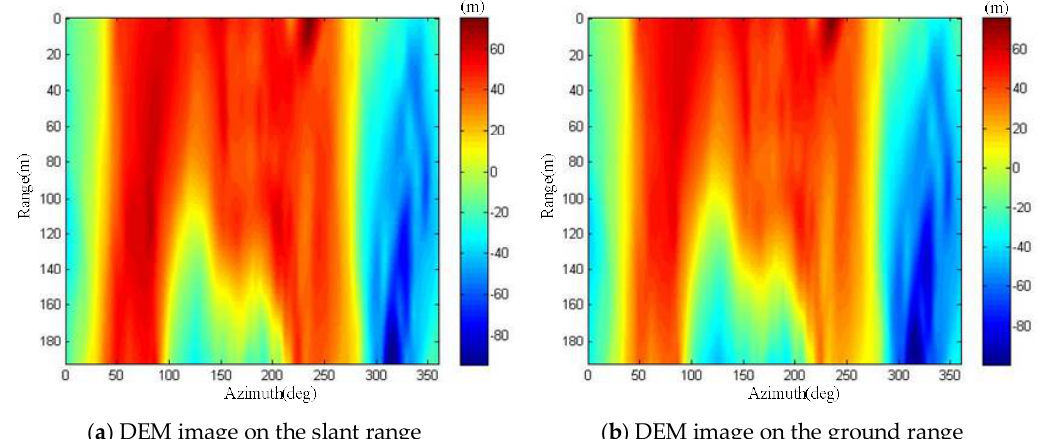
Figure 20. Interferometric ArcSAR extraction the DEM image of scenes.